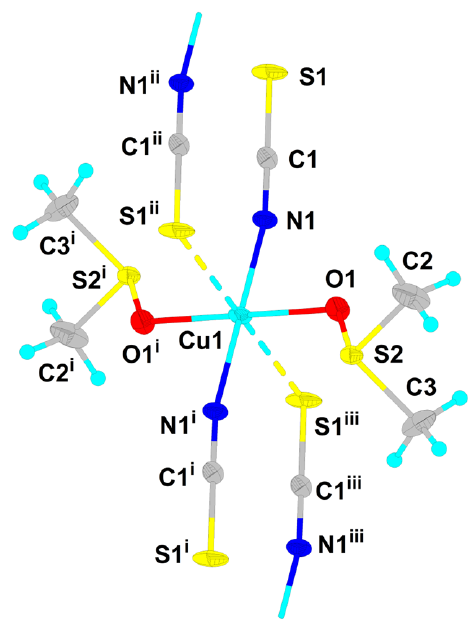
Figure 5. The molecular structure of 4 . Thermal ellipsoids are drawn at the 50% probability level. Symmetry operations: 1 − x, 1 − y, 1 − z (i); − x, 1 − y, 1 − z (ii); 1 + x, y, z (iii). Compound 5 consists of Hdabco + cations and SCN − anions associated via N-H . . . N rather strong (N . . . N 2.763(2) Å) hydrogen bonds (Figure 7). (Hdabco)SCN moieties are bound via weak interactions only. The Hdabco moiety has an untwisted geometry. The HN-C and N-C distances are clearly different (Table